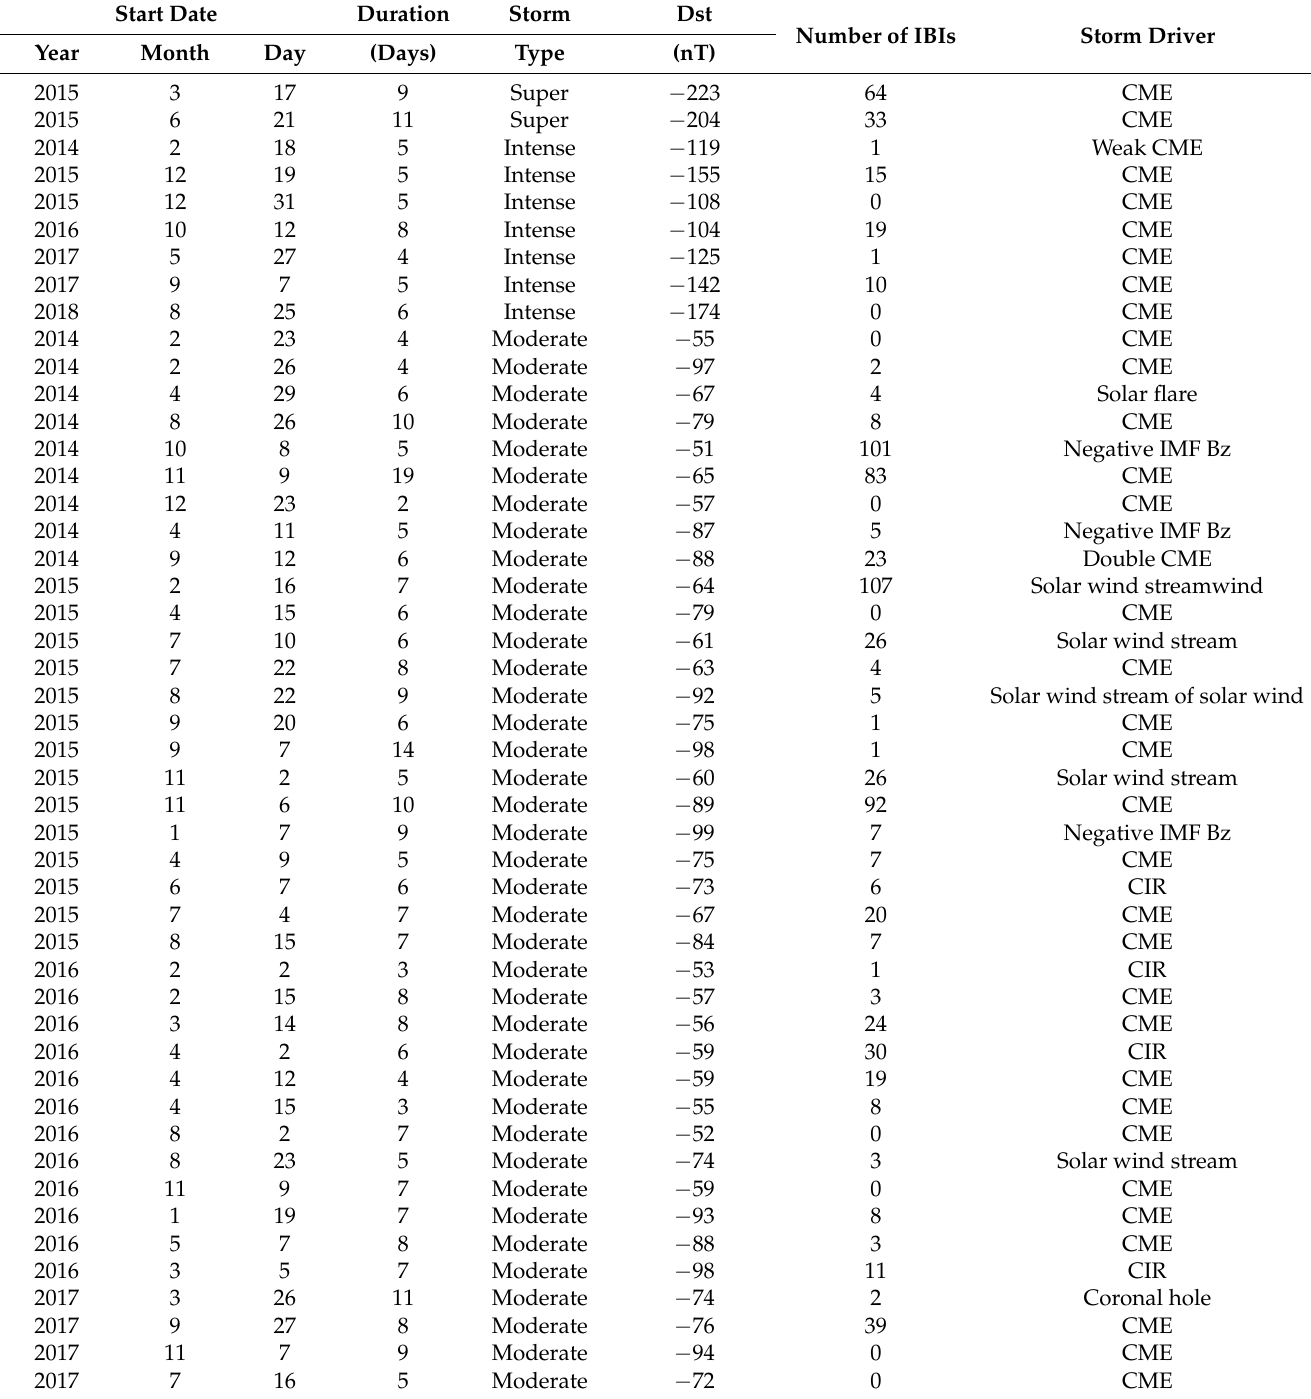
Table 2. Geomagnetic storms recorded during 2014–2020. Columns from left to right are year, month, day, duration of geomagnetic storm, type of storm, Dst index the number of IBIs occurring from the beginning of the storm until the end of the recovery phase, and finally, the geomagnetic storm